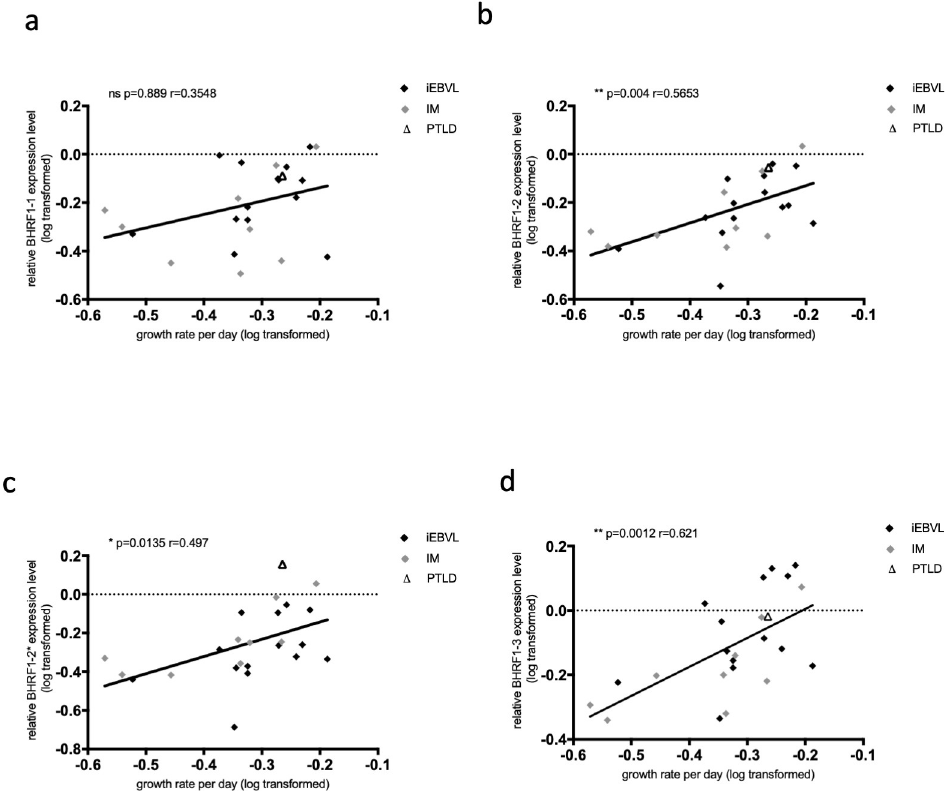
Fig 4. The growth of cells infected with EBV correlates with the BHRF1 miRNA expression level. We calculated the correlation coefficients between the growth rate of the investigated sLCLs and the expression of each of the BHRF1 miRNAs (a-d). The values of the growth rates have been log-transformed to obtain a normal distribution.